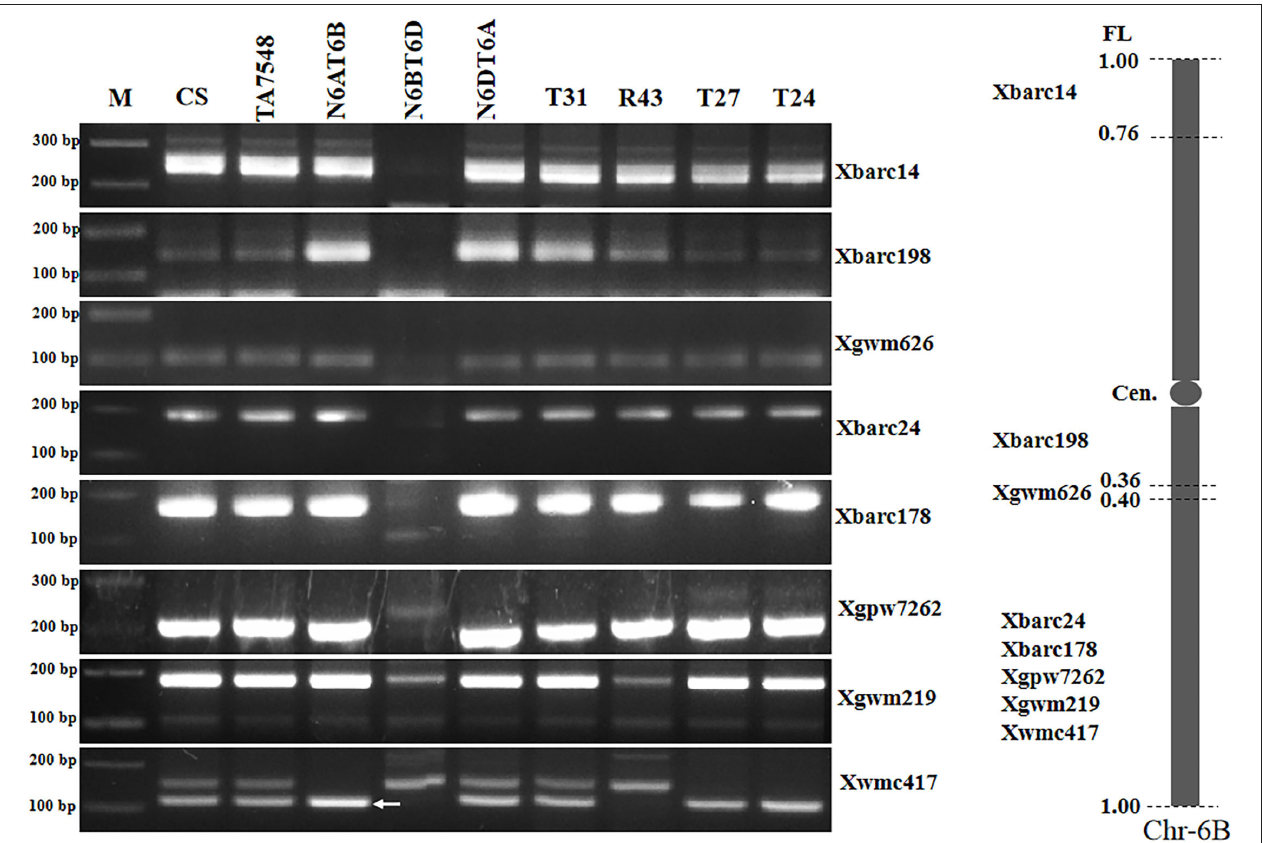
FIGURE 6 | Molecular markers analysis of 6S l #3 recombinants using wheat 6B SSR markers. Arrows pointed to 6B-specific bands when two or more bands were amplified using a single primer pair. M: 100 bp DNA ladder